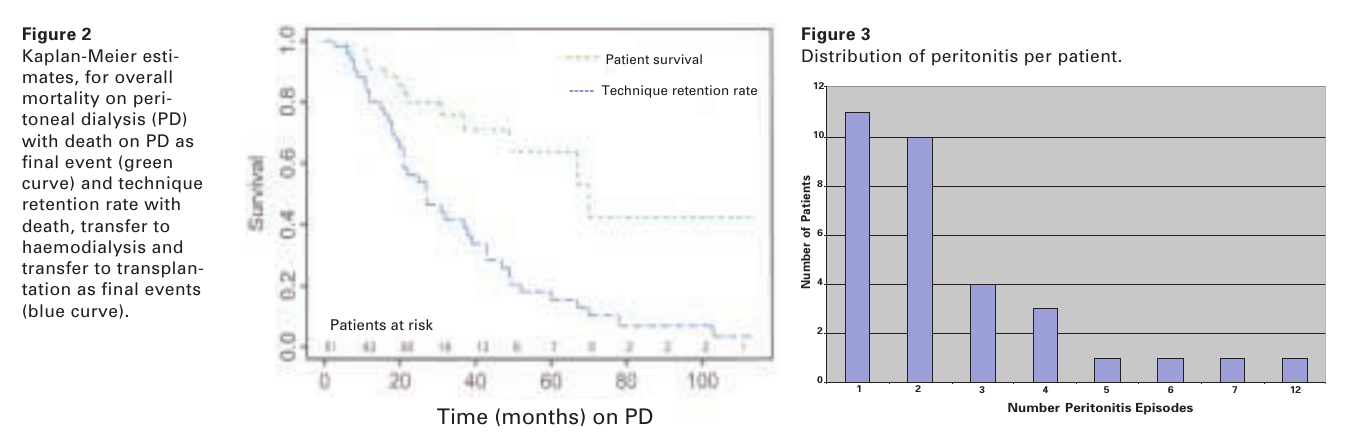
Figure 3 Distribution of peritonitis per